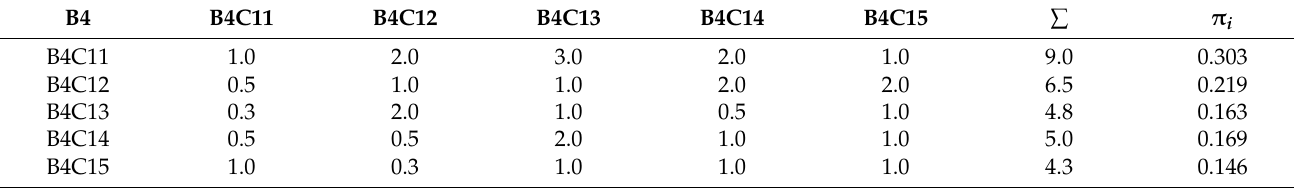
Table 10. Matrix of pairwise comparisons (Level 3).